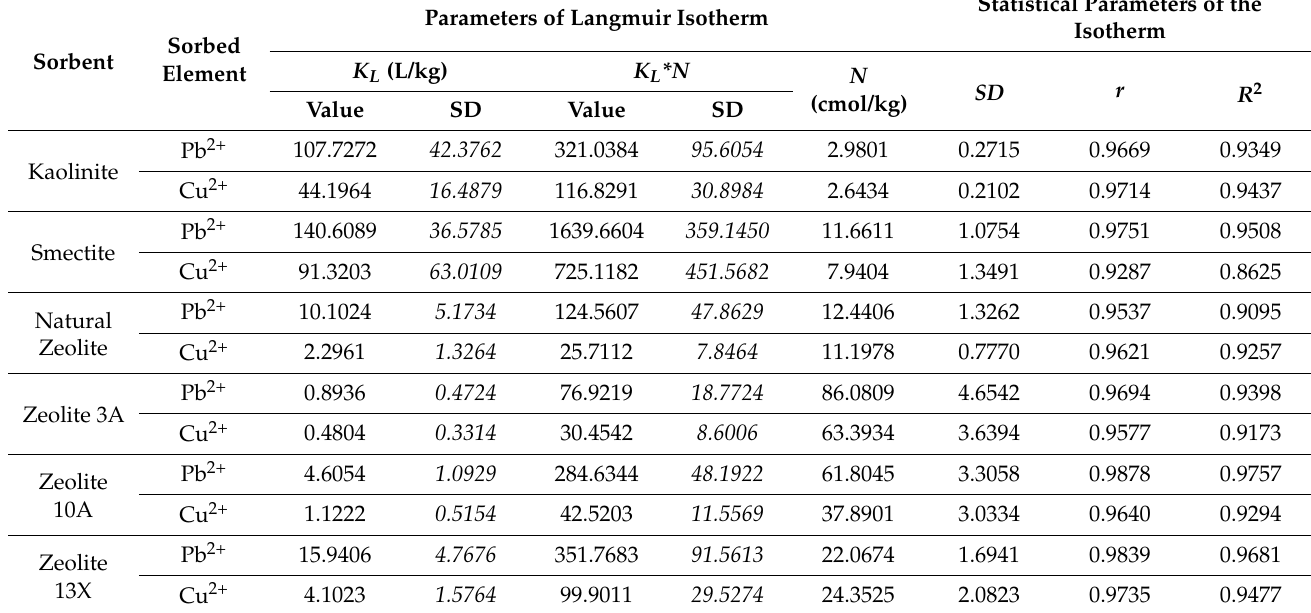
Table 5. Parameters of Langmuir isotherms and isotherms’ statistical